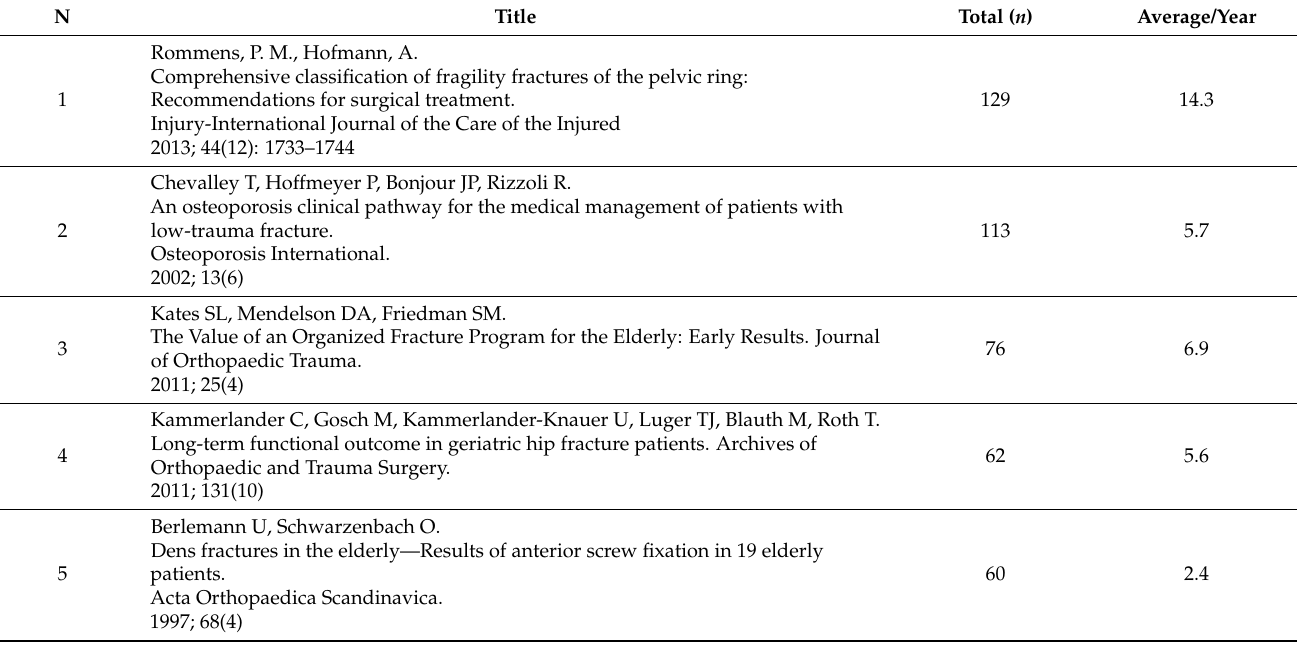
Table 1. List of the identified 10 most cited articles in the field of fragility fractures according to the amount of total citations with average citations per year.